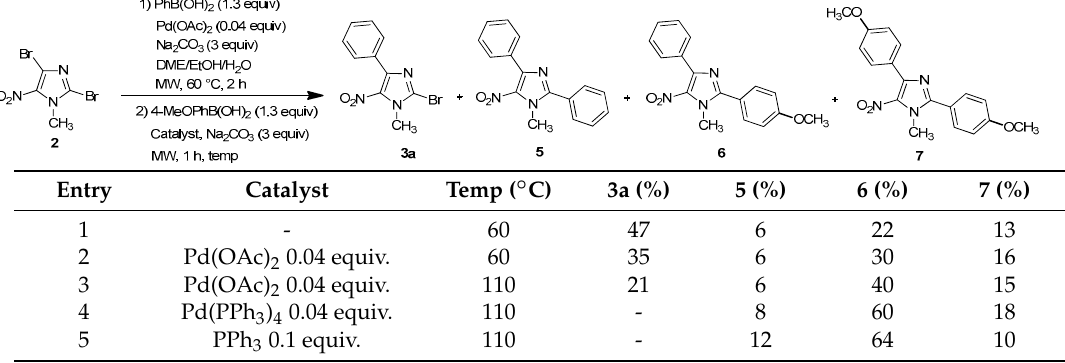
Table 3. Optimization of the second step of the one-pot regioselective bis-Suzuki-Miyaura reaction.